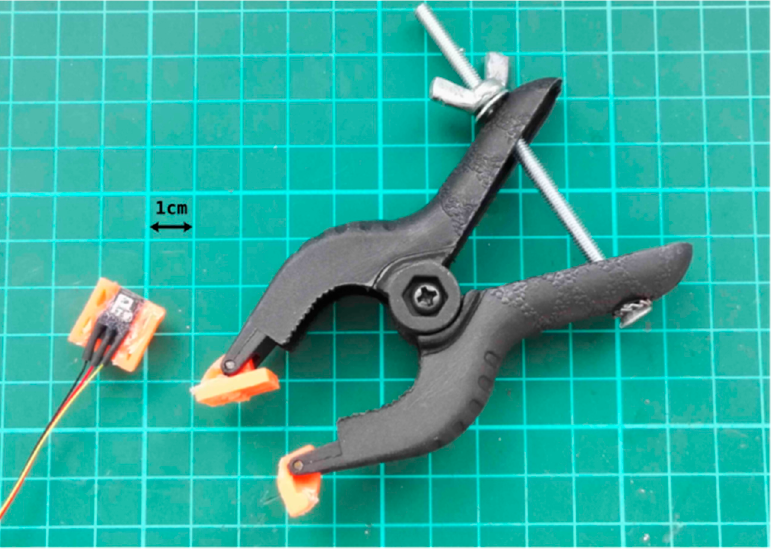
Figure 4. Custom clamp supporting both optical probes. T-probe is shown on the left (cm: centimeter).